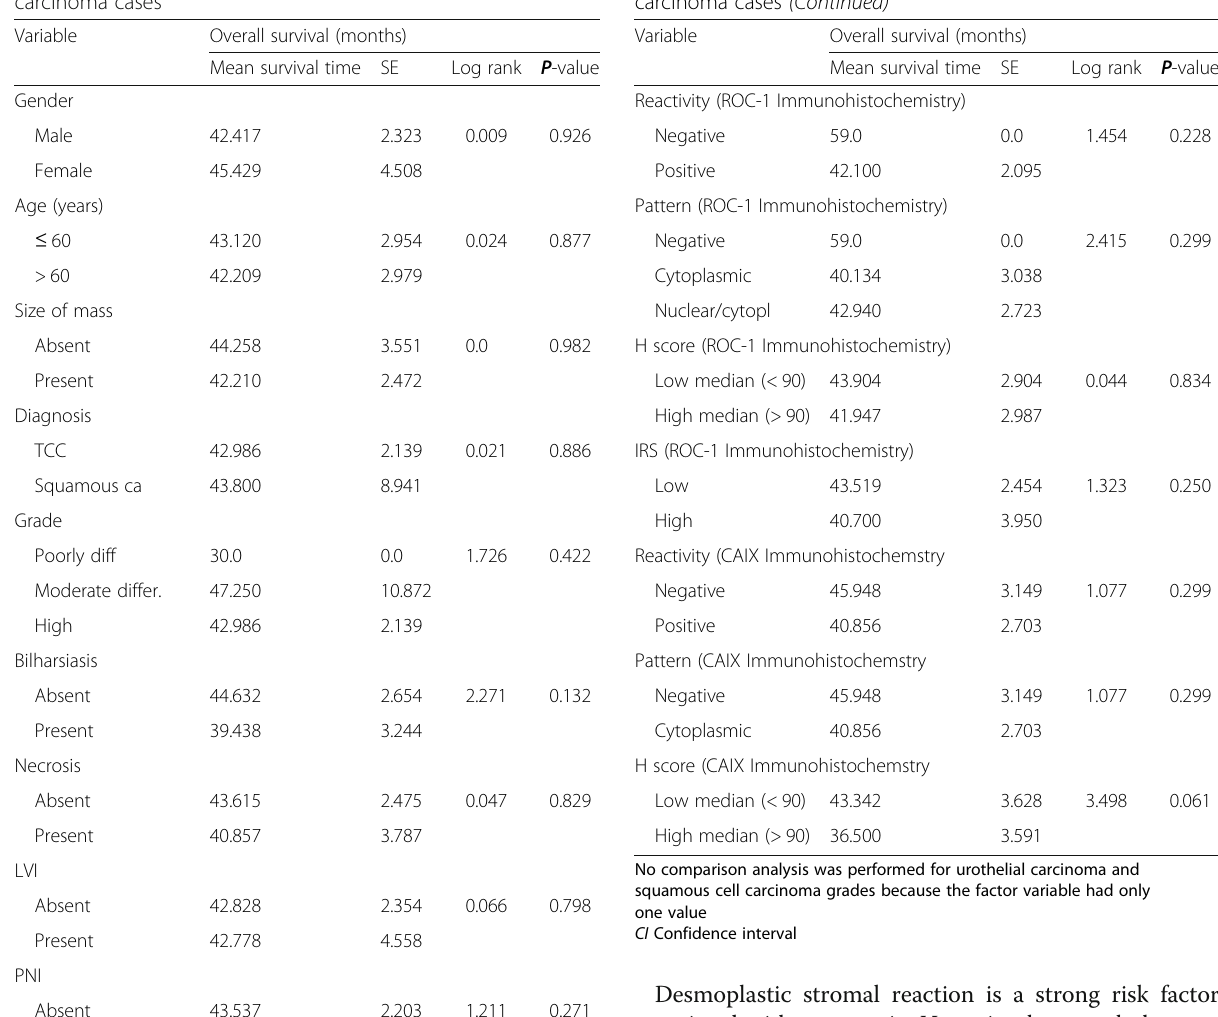
Table 6 Univariate survival analysis for studied